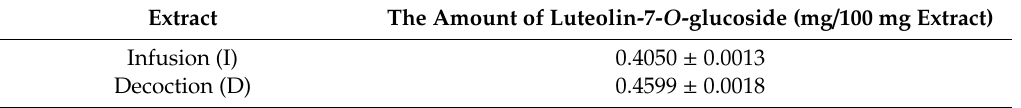
Table 3. The composition of the gradient (A:B) for luteolin-7- O -glucoside. The Amount of Luteolin-7- O -glucoside Extract (mg/100 mg Extract)